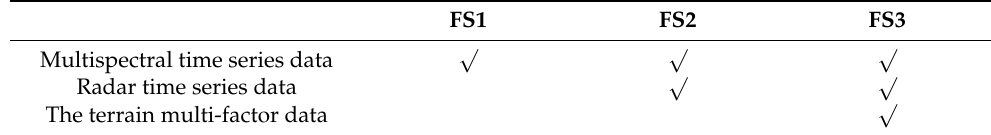
Table 4. Scenarios design based on input feature